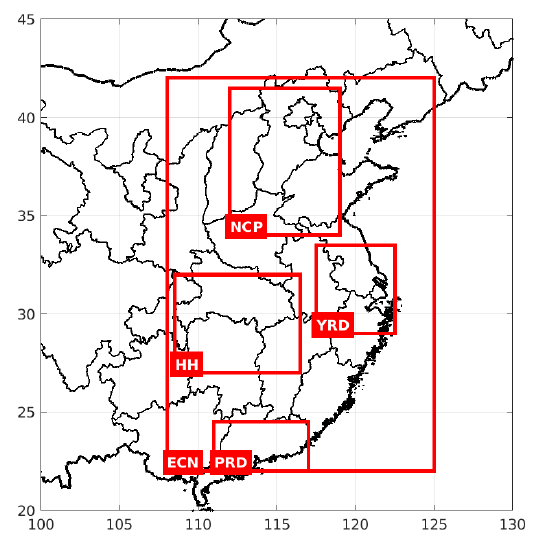
Figure 4. Regions used in this study. ECN = eastern China (22–42°N, 108–125°E); NCP = North China Plain (34–41.5°N, 112–119°E); YRD = Yangtze River Delta (29–33.5°N, 117.5–122.5°E); HH = Hubei–Hunan (27–32°N, 108.5–116.5°E); PRD = Pearl River Delta (22–24.5°N, 111–117°E).